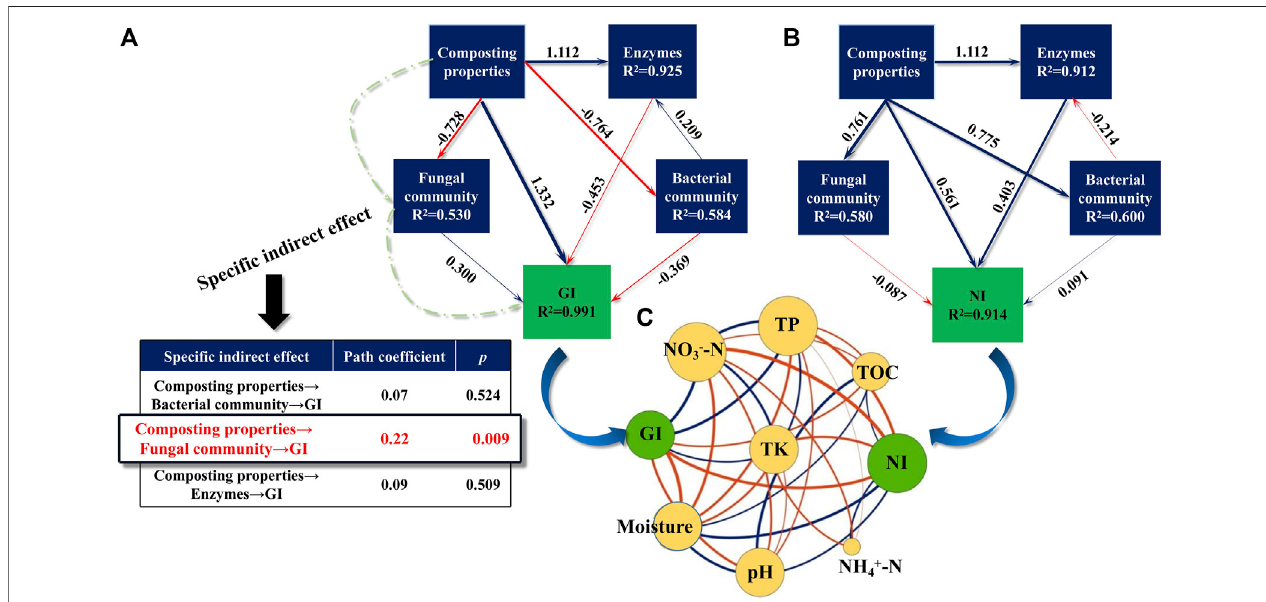
FIGURE 6 | Structural equation models (SEMs) showing the pathways (A,B) of the different factors (environmental factors, enzymes and microorganisms) on compost maturity (GI and NI). The path coef fi cients are adjacent to the arrows. Blue and red lines indicate the positive and negative pathway. Co-occurrence networks betweenmaturityindexesandabioticfactors (C) .Aconnectionisobservedforstrong(Spearman ’ s ρ > |0.6|)andsigni fi cant( p < 0.05)correlationsamongthesevariables. The green nodes indicate the parameters of maturity indexes while the orange nodes indicate biotic factors. The size of nodes is proportional to the degree of connectivity. Blue links indicate negative interactions between two individual nodes, while red links indicate positive interactions.